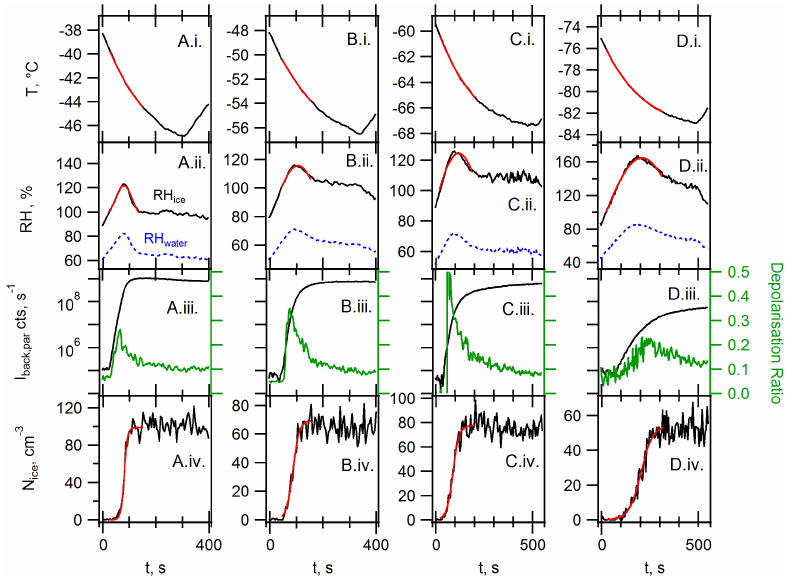
Figure 1. Temporal plots of the representative AIDA deposition-mode freezing experiments with various cooling ranges, including A. HALO06_19, B. HALO06_21, C. HALO05_18 and D. HALO05_24. Panels are arranged to show the measurements of i. AIDA mean gas temperature ( T ), ii. TDL, iii. SIMONE and iv. ice crystal concentration ( N ice ). Note that the red lines represent interpolated data used for the n s -isoline formulation. The I back,par in the panel iv axis denotes the backscattered light scattering intensity parallel to the incident polarization state (log-scaled). An increase in the depolarization ratio indicates the formation and growth of ice crystals.